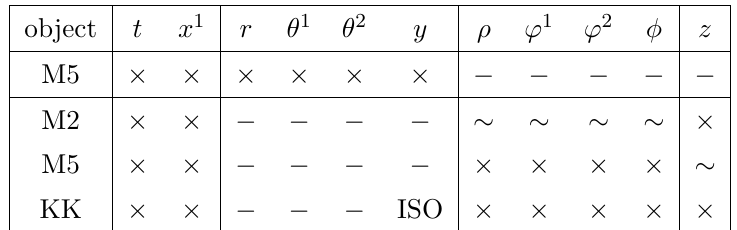
-BPS brane setup of defect M2–M5 branes intersecting orthogonal M5 branes with KK Table 2 . 1 8 monopoles. y is the compact direction of the KK monopoles